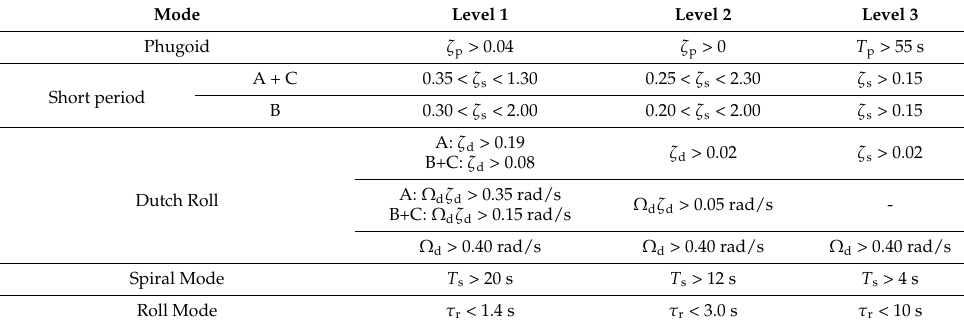
Table 10. Longitudinal and lateral handling qualities criteria.